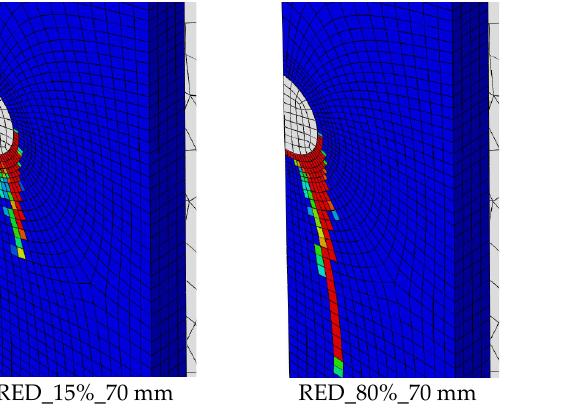
Figure 19. Final shear damage distribution for 70 mm of cover for the double-lap test, with re- duced/full integration (RED/FULL) with 15% and 80% residual compressive stress. In Figure 20a, the shear stress and shear damage evolution are presented in the Gauss point nearest the circular opening perimeter at 30° of the symmetry axis in the GFRP plate.